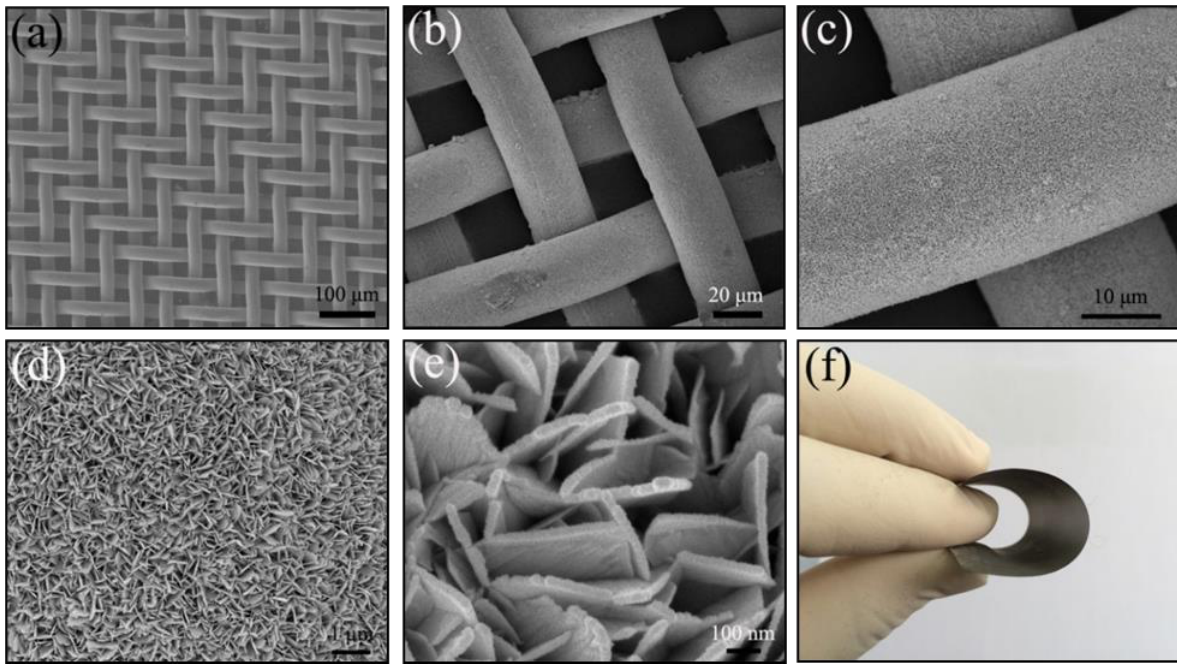
Figure 4. SEM images of ( a ) pristine copper microfibre cloth, where sub-millimetre pores can be clearly observed; ( b ) and ( c ) low magnification images of the copper textile surfaces after SnO 2 nanosheets layers are grown; ( d ) and ( e ) high- magnification SnO 2 nanosheets; ( f ) shows a photo of a piece of folded copper textile coated SnO 2